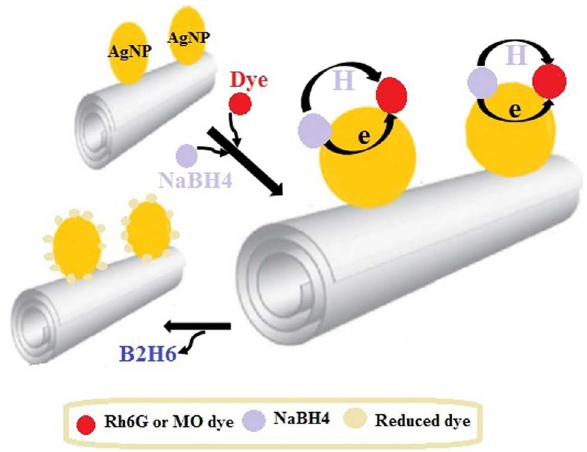
Fig 10. Proposed mechanism of reduction of dyes by catalytic sam- ple.